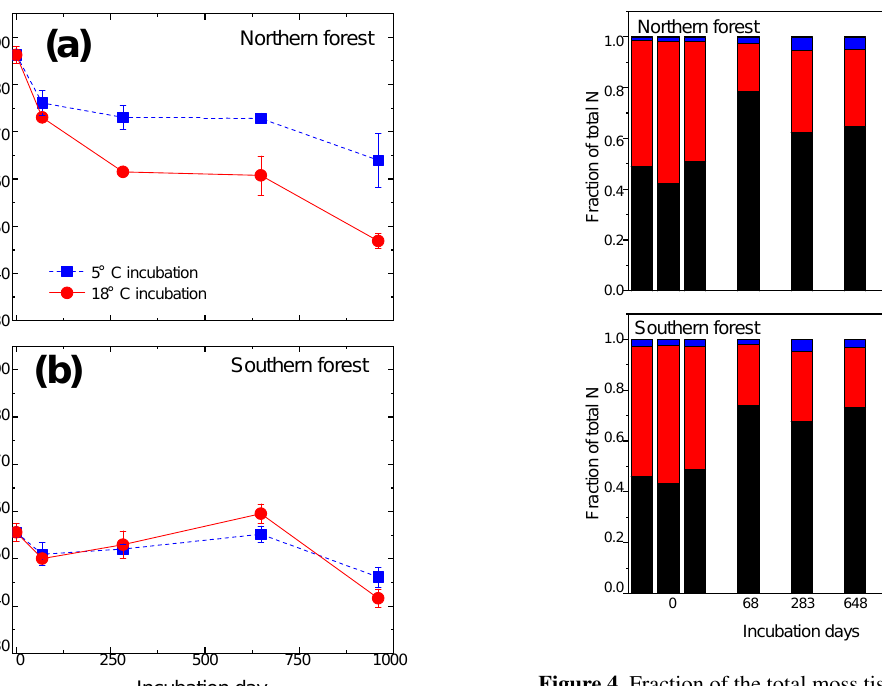
Figure 4. Fraction of the total moss tissue N content as nitrate, am- monium, total hydrolyzable amino acids (THAAs), and molecularly unidentified N (MUN) in each sample. Total hydrolyzable amino acids were only reported for one triplicate of the 18 ◦ C incubations for the middle time points (69, 283, and 648 days), though all sam- ples were tested for the inorganic N